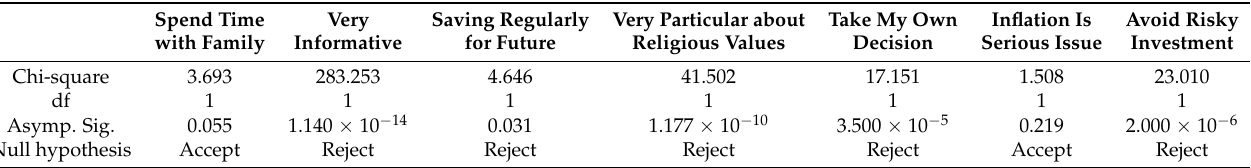
Table 6. Kruskal–Wallis one-way ANOVA between psychographic factors and buying behaviour. Spend Time Very Saving Regularly Very Particular about Take My Own Inflation Is Avoid Risky with Family Informative for Future Religious Values Decision